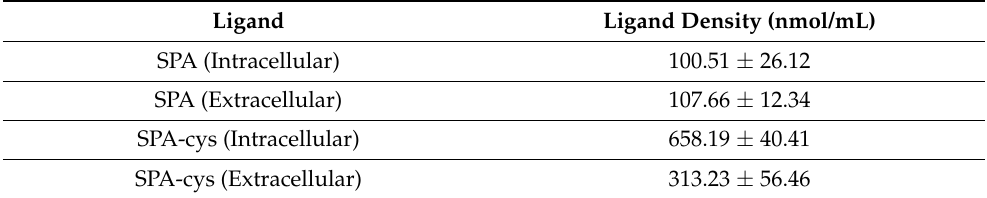
Table 4. Overview of coupled proteins with their densities in epoxide